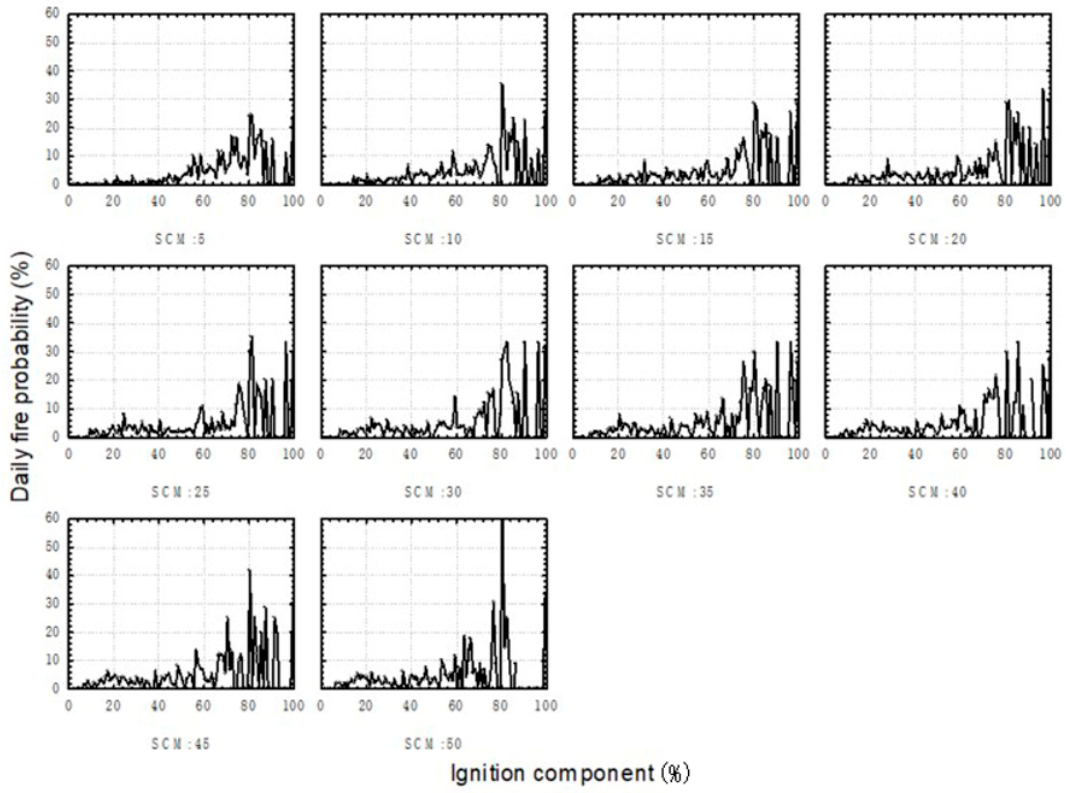
Figure 2. Daily fire probability and IC computed using different SCM values.